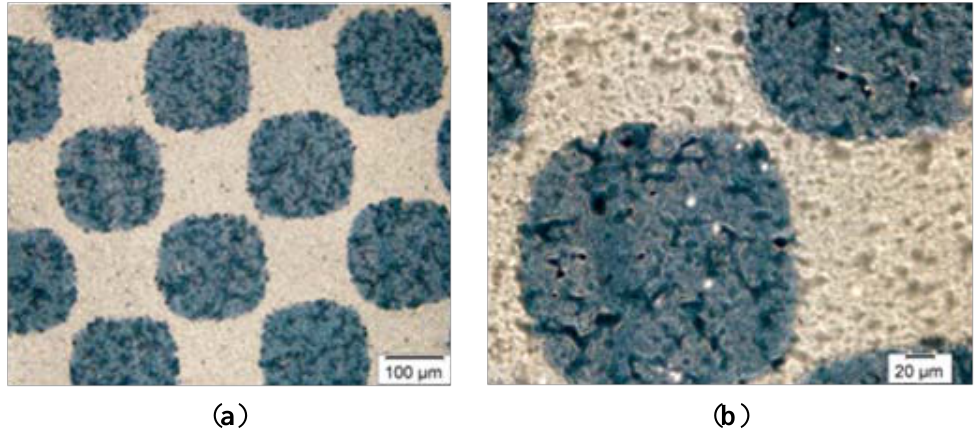
Figure 1. The surface structure of an offset printing plate.